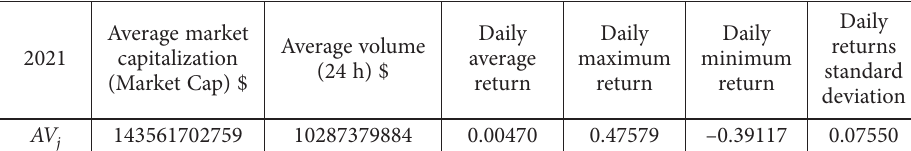
Table 2. AV j values (source: compiled by the